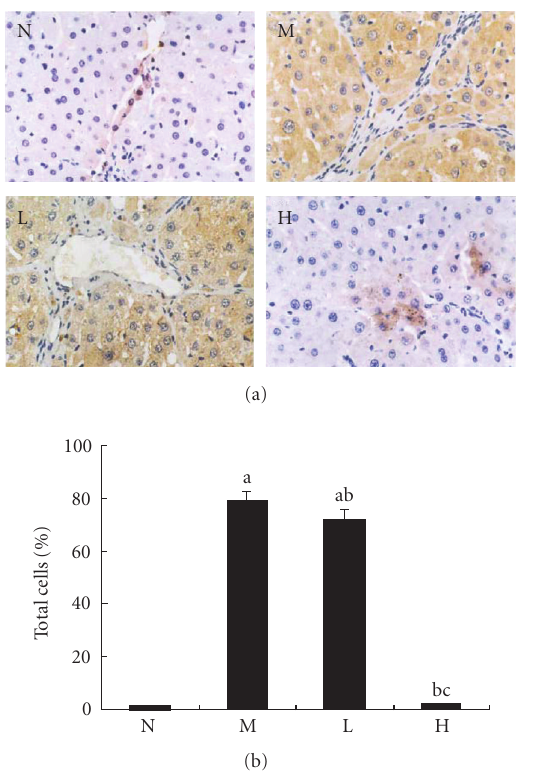
Figure 5: Immunohistochemical staining for ICAM-1 in rat liver. N represented the normal control group; M represented the model group; L represented the group treated with low dose of thalido- mide; H represented the group treated with high dose of thalido- mide. (a) Positive ICAM-1 cells were mainly distributed at the fi- brosepta band, area of necrosis, and inflammatory cell infiltration in hepatic lobules (M, L, and H) (original magnification N, M, L, H, × 400, immunohistochemical staining). (b) Comparison of the ex- pression of ICAM-1 using immunohistochemical analysis. a P < . 01 versus normal control group; b P < . 01 versus model group; c P < . 01 group treated with high dose of thalidomide versus group treated with low dose of thalidomide.